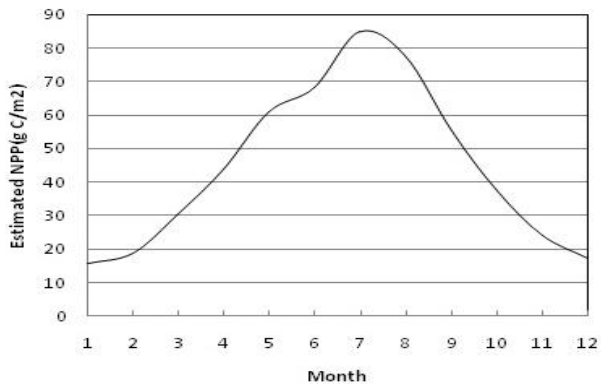
Figure 5. NPP monthly changes trend from 2001 to 2011.